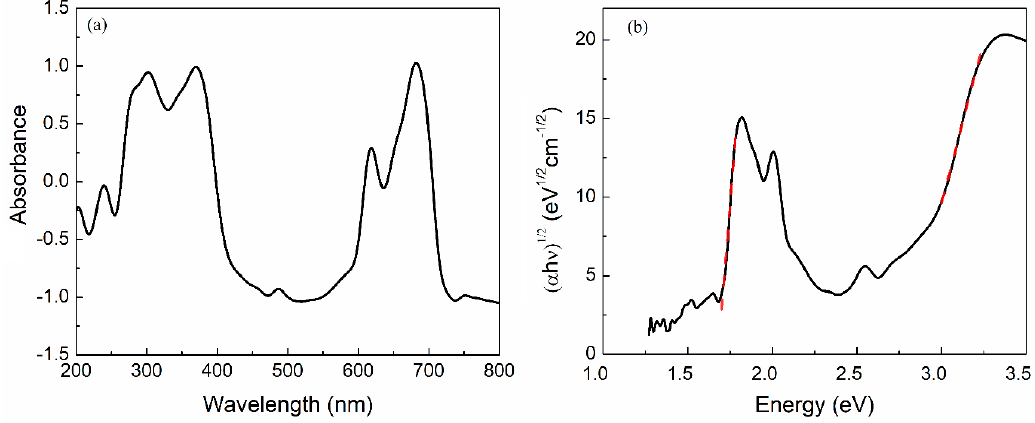
Figure 7. ( a ) UV-Vis of the flexible OFET and ( b ) Tauc Plot.